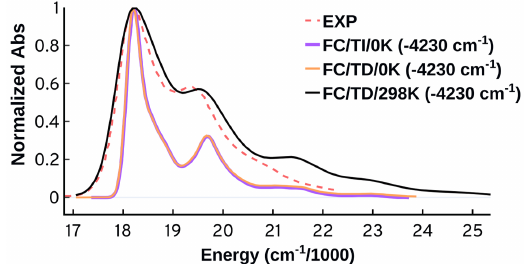
Figure 9. Temperature effect in the time-independent (TI) and time dependent (TD) schemes. The adi- abatic Hessian (AH) approach at 0 K and 298 K was used along with structures optimized using ω B97XD/Def2SVP in the gas-phase. The spectra are normalized and shifted to match the maximum of the experimental